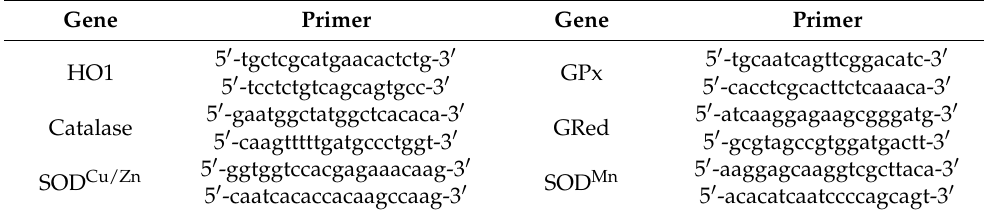
Table 3. Sequence of the primers used for real-time